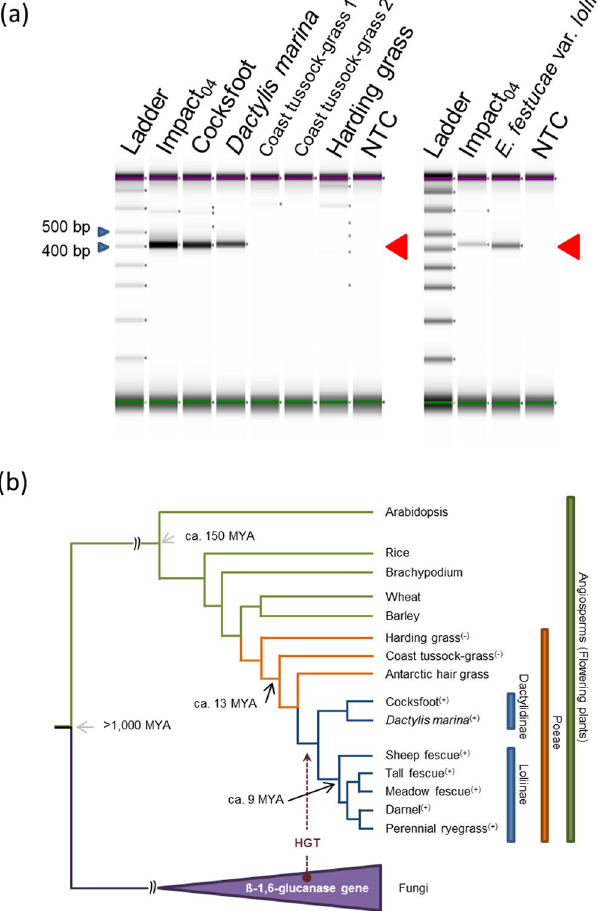
Figure 5. PCR screening for the Lp BGNL sequence, and taxonomic classification of plant species described in the current study ( a ) PCR amplicons from perennial ryegrass genotype Impact 04 , cooksfoot, Dactylis marina , coast tussock-grass and harding grass, and a strain of E . festucae are visualised on the 2200 TapeStation instrument (Agilent Technologies, CA, USA). The target fragments are indicated with the red arrow. Two genotypes of coast tussock-grass were subjected to the screening. The purple and green lines show the position of upper and lower markers, respectively, of the D1000 Kit (Agilent). NTC denotes no-template control for the PCR assay. The blue arrows indicate the positions of 400 and 500-bp fragments of the ladder. ( b ) Species classified into angiosperms, the tribe Poeae, and sub-tribes Loliinae and Dactylidinae are indicated by the green, orange and blue boxes, respectively, on the right side of the phylogenetic tree. The species which were positive and negative in the PCR screening step are indicated by the plus ( + ) and minus ( − ) signs, respectively. The divergent points of plant species from other species ( > 1,000 MYA) and the clade monocotyledon from other plant species (ca. 150 MYA) are indicated with light grey arrows. The divergent points of sub-tribes Loliinae and Dactylidinae from the remaining Poeae species, especially from genus Poa , which is a closely related taxon (ca. 13 MYA), and fine-leaved fescue (Sheep fescue) from broad-leaved fescues (tall fescue and meadow fescue) (ca. 9 MYA) are indicated with black arrows. The purple arrow represents the putative period of HGT in the evolutionary